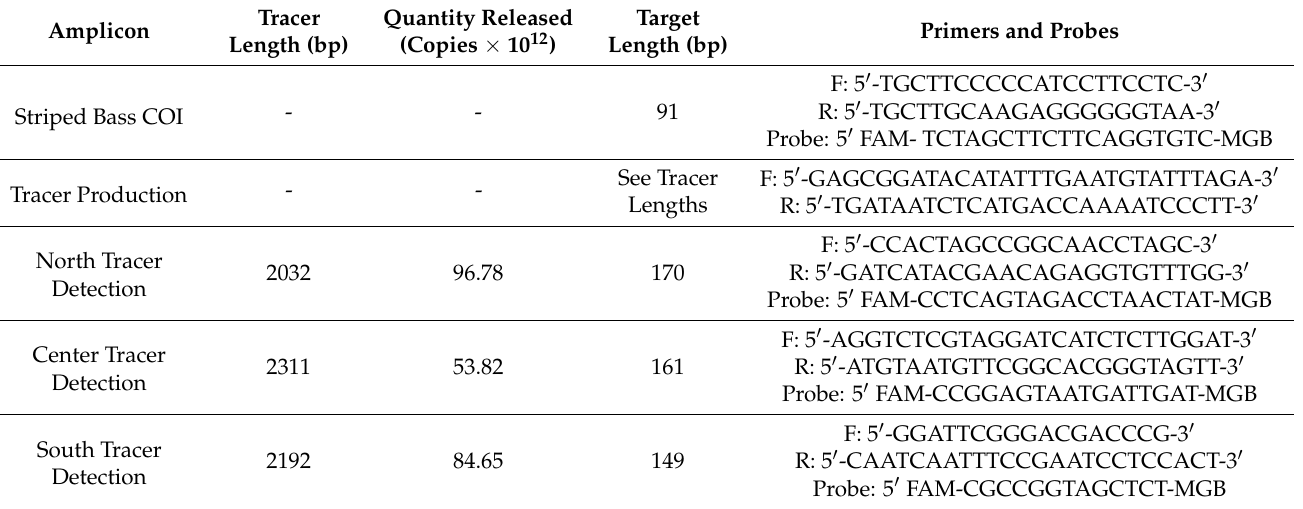
Table 1. PCR and qPCR assay information for striped bass eDNA detection, tracer production and tracer detection. The table contains the primers and probes used for each assay, and the length of the target sequence that they amplify. Tracers are named according to the location of release in transect 5; for each: tracer length and quantity released refer to the linearized plasmid PCR amplicons used as tracers, and target length refers to the sequence detected by qPCR from filtered water sample DNA